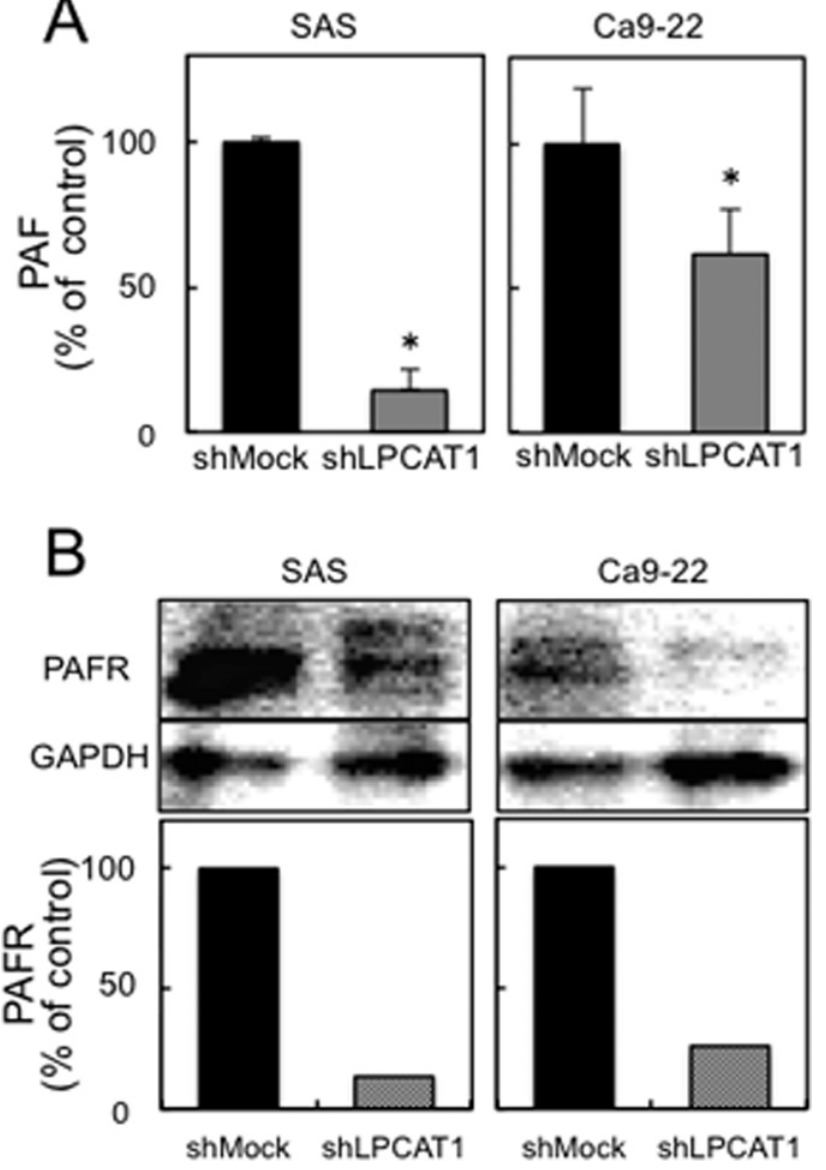
Fig 4. Reduced PAF synthesis and PAFR expression in shLPCAT1-transfected cells. ( A ) Evaluation of intracellular PAF concentration in shMock- and shLPCAT1-transfected cells (SAS- and Ca9 – 22-derived transfectants). To determine the intercellular PAF concentrations, we examined cellular lysates using ELISA and normalized with protein concentration. The mean value was calculated from the data obtained from three independent samples. The relative PAF concentration in the shLPCAT1-transfected cells is decreased significantly ( * p < 0.05, the Mann-Whitney U test) compared with the shMock-transfected cells. ( B ) Evaluation of PAFR expression in shMock- and shLPCAT1-transfected cells (SAS- and Ca9 – 22-derived transfectants). Immunoblot analysis shows that PAFR protein expression in the shLPCAT1-transfected cells is decreased markedly compared with the shMock-transfected